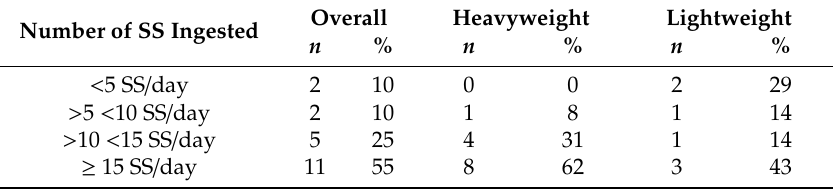
Table 2. Overall number and percentage of SSs ingested by heavyweight and lightweight rowers. Number of SS Ingested